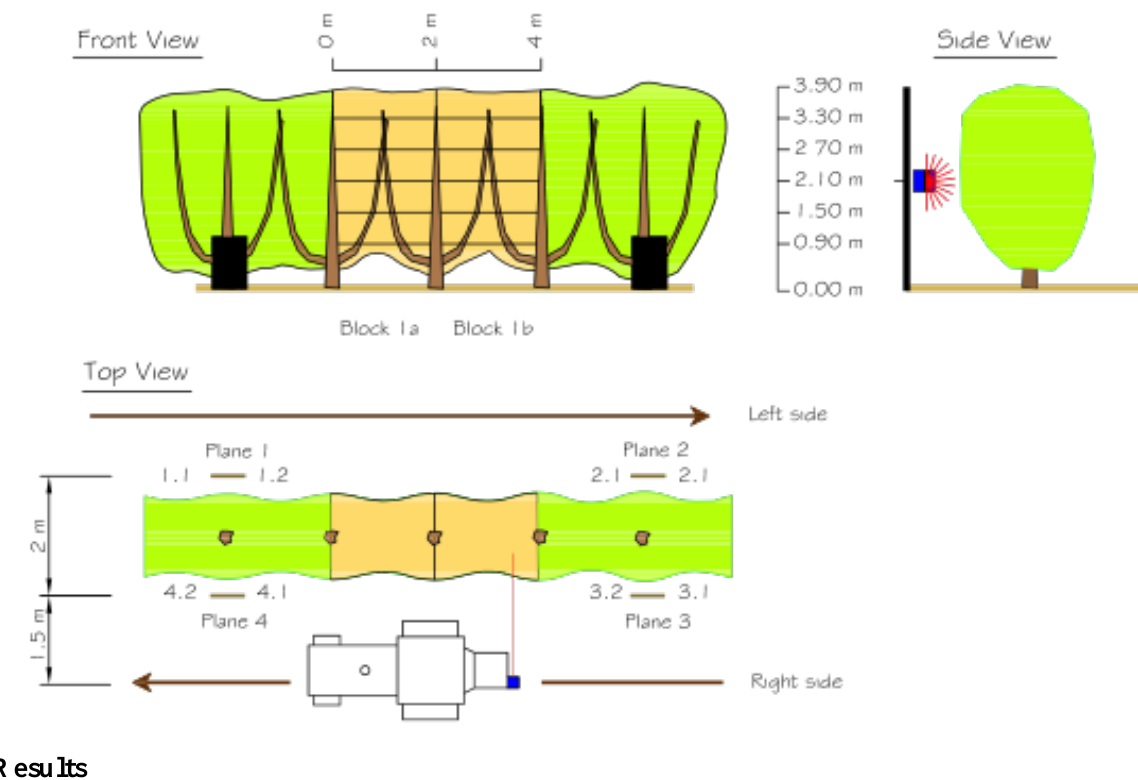
Figure 9. Schematic description of the tests performed in a pear tree orchard ( Pyrus communis L. cv Blanquilla) in Lleida, Spain.